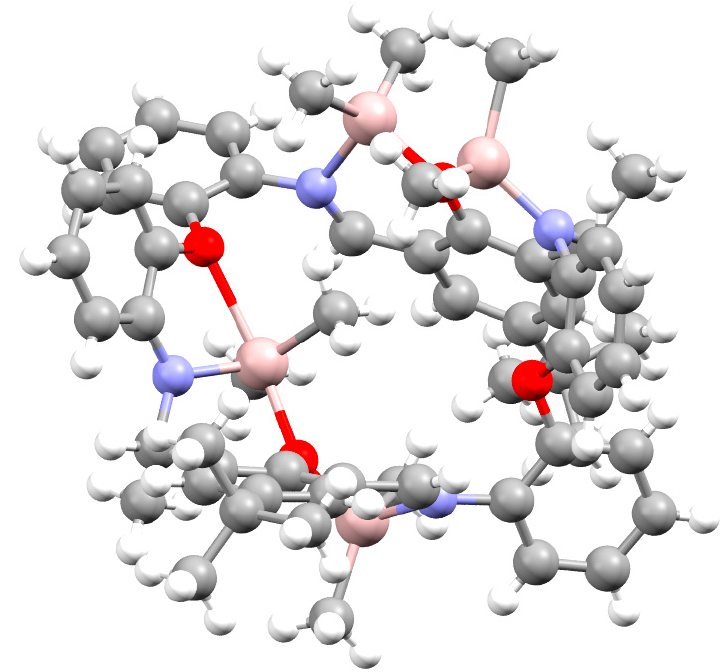
Figure 1. Molecular structure of tetranuclear complex ( 19 ).